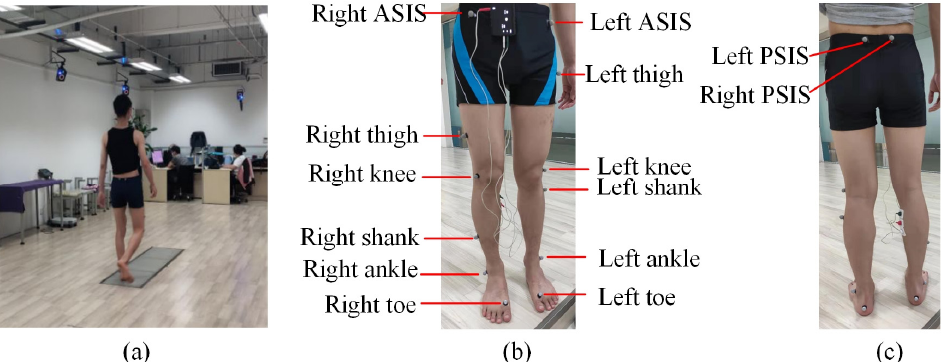
Figure 2. Measurement of lower limb displacement during level ground walking. ( a ) The experimental setup; ( b ) the reflective markers on the front side; and ( c ) the reflective markers on the back side.